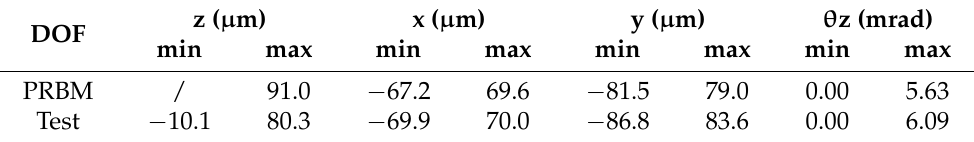
Table 9. Comparison of the workspace in terms of the kinematics performance.